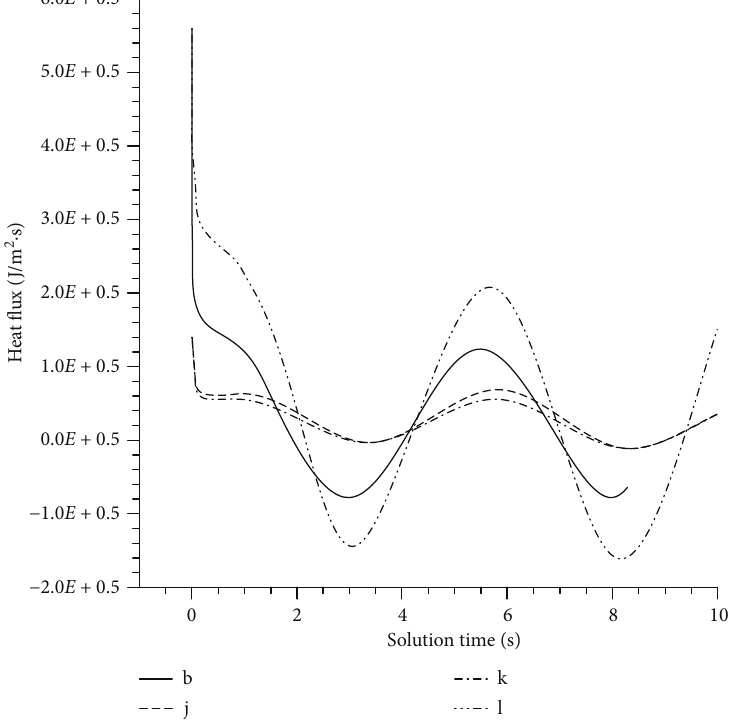
Figure 7: The variation of heat fl ux with time under di ff erent